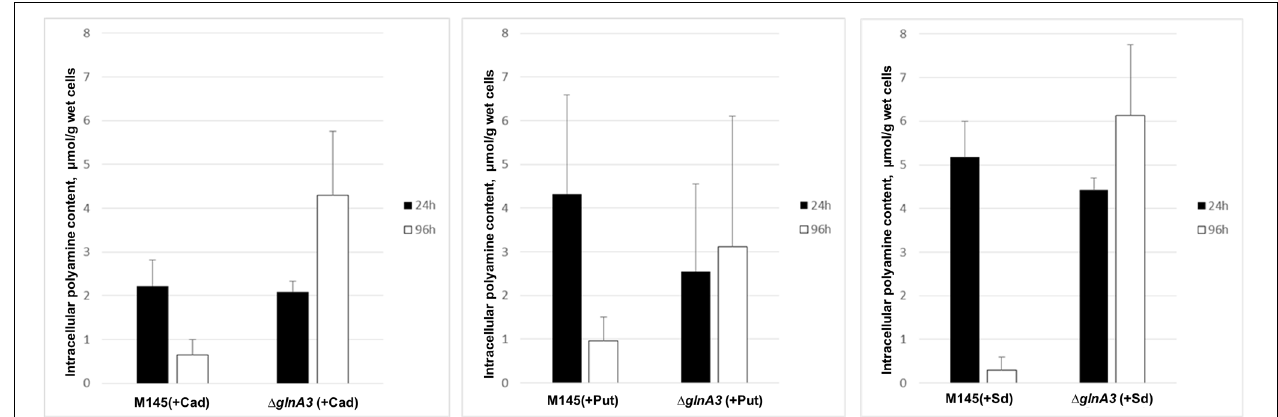
FIGURE 6 | Effect of glnA3 deletion on intracellular polyamine concentration. The intracellular polyamine level of parental strain S. coelicolor M145 and (cid:49) glnA3 mutant was monitored after 24 and 96 h of cultivation in defined Evans medium supplemented with polyamines (Put – putrescine; Cad – cadaverine or Sd – spermidine, 25 mM of each). The mean value of three biological replicates was calculated in µ mol per 1 g of wet cells. Error bars indicate standard error of three biological replicates.